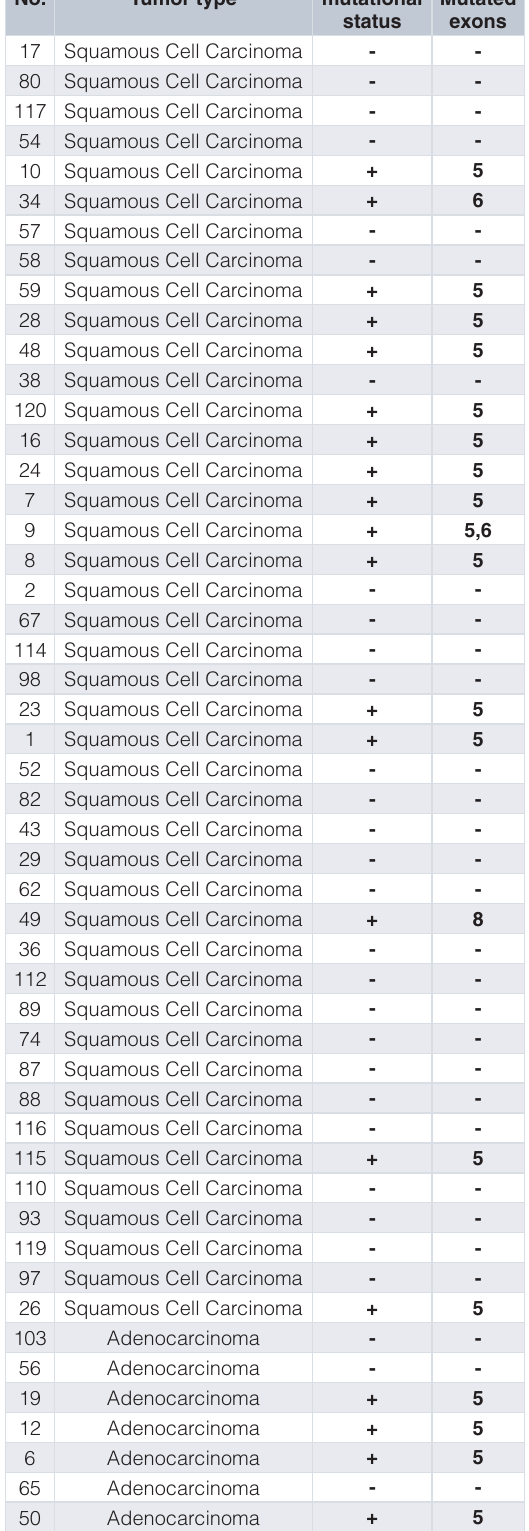
Table 2. Histopathological diagnosis, mutational status and exons affected in esophageal cancer patients.